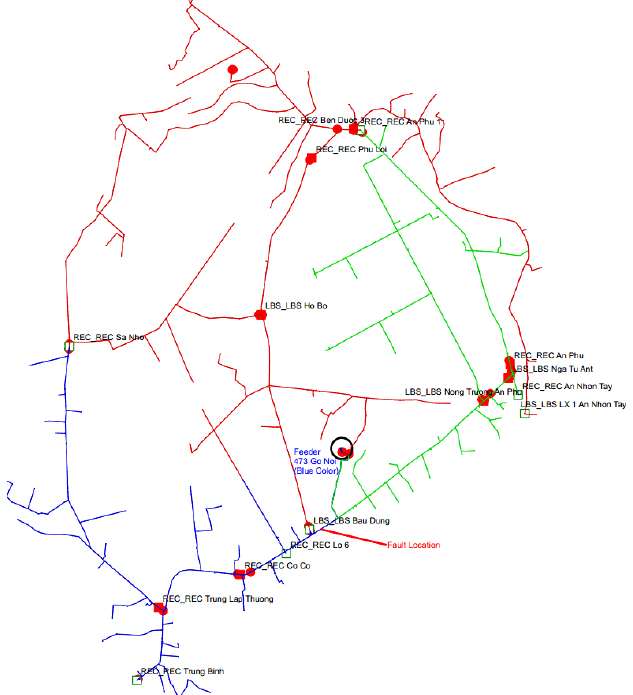
Figure 7. A geographical mapping of the BAU DUNG power substation.